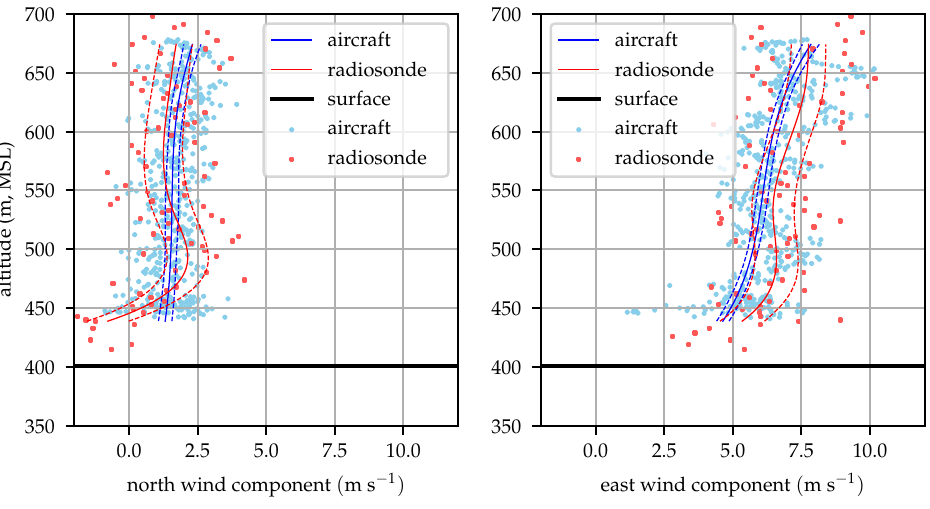
Figure 15. Aircraft and radiosonde profiles from 09:00 local time